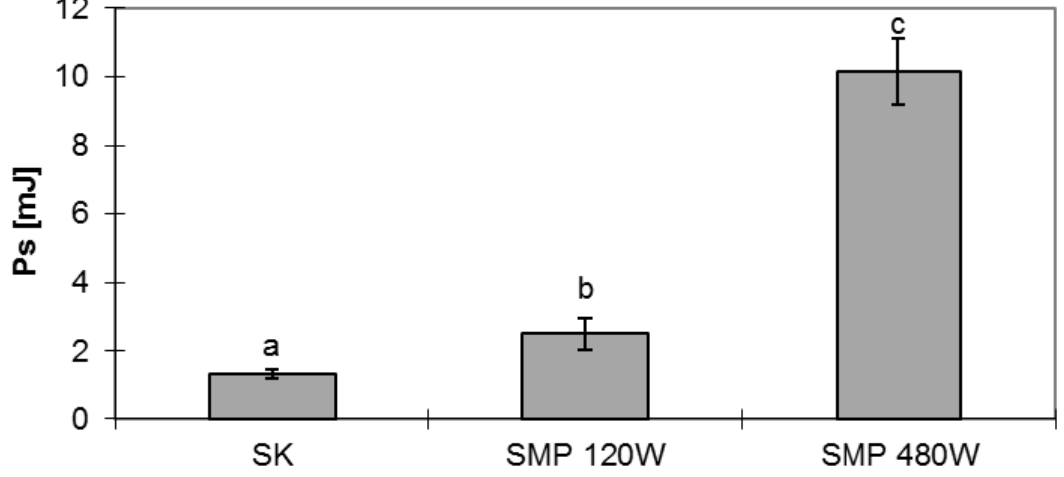
Figure 1. Values of compression work for dried Physalis. SK—convective method; SMP—microwave method under reduced pressure 120 W and 480 W; Mean values with different letters (a, b, c) within the same columns are statistically different ( p = 0.05).